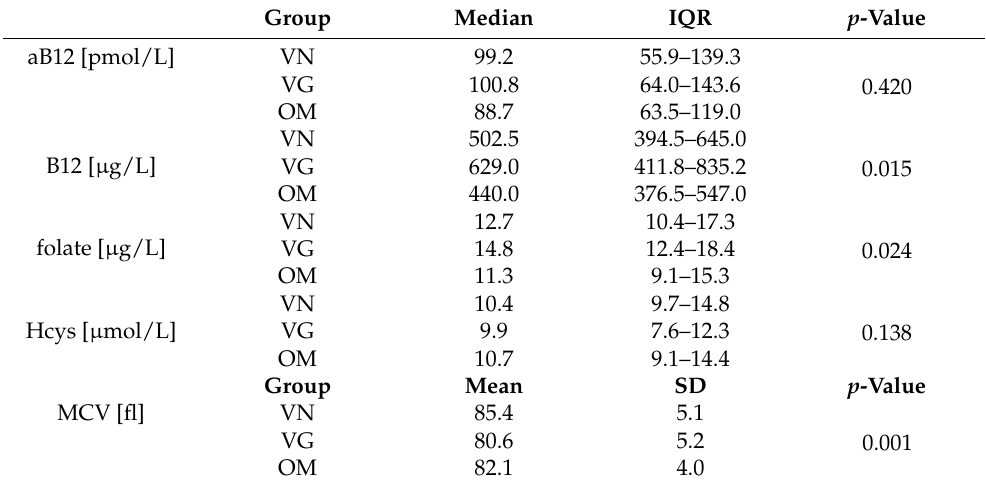
Table 9. Mean values of selected blood markers across VG/VN/OM “Schoolers” (aged 4–18 years).